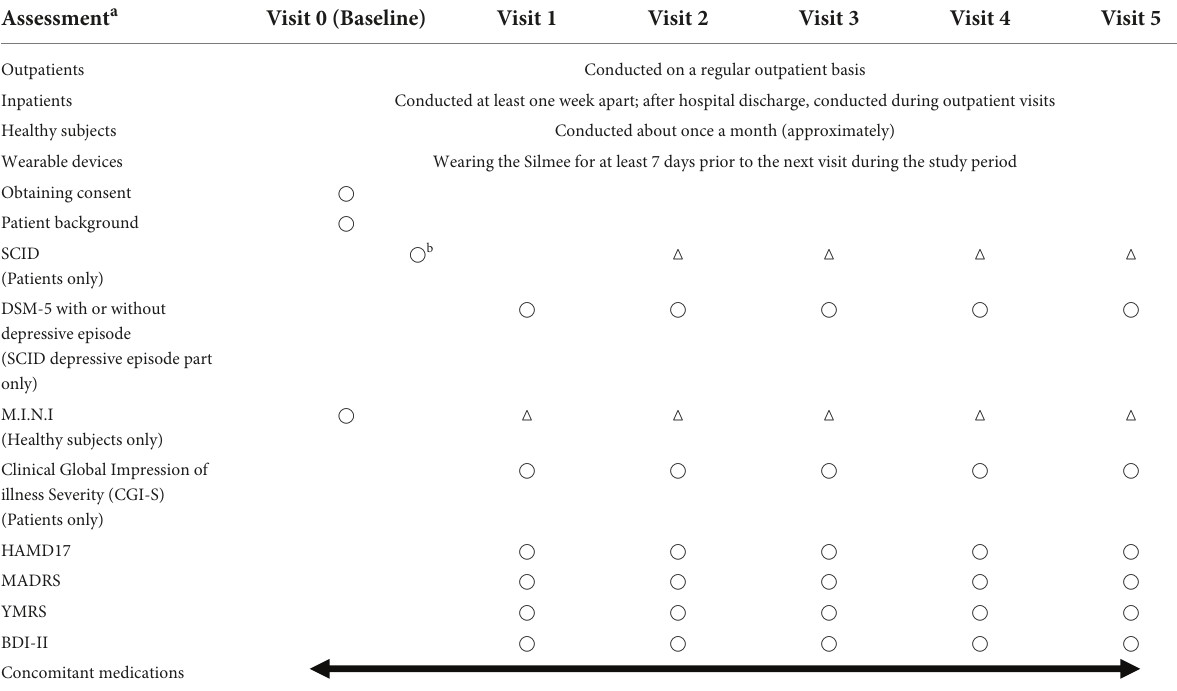
TABLE 1 Schedule for data collection and evaluations during the observation